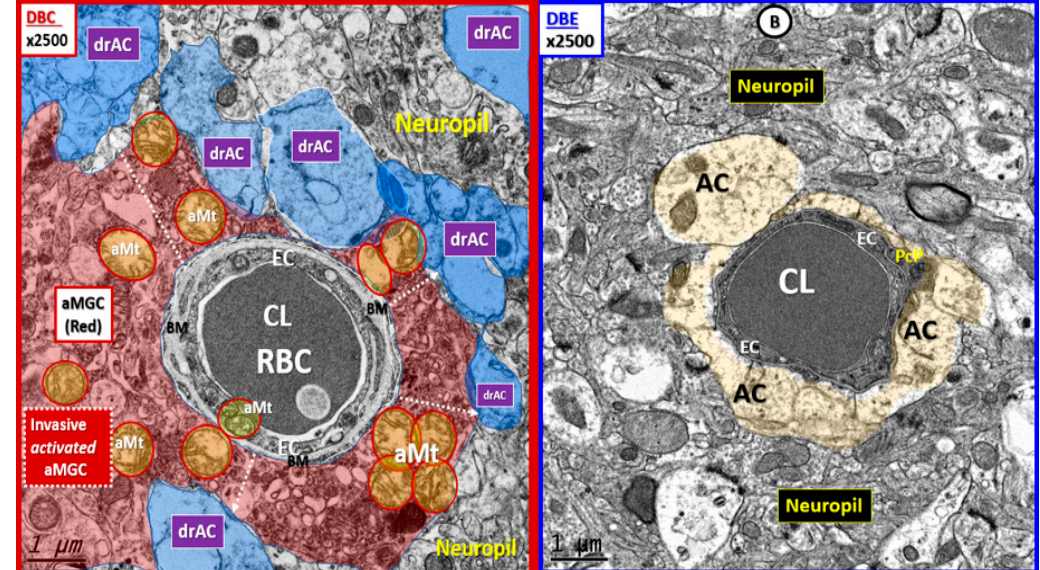
Figure 4. Basement membrane thickening, activated microglia invasion, and detachment of astrocyte foot processes are protected with empagliflozin. Panel ( A ) depicts the invasion of the activated MGC (aMGC) to totally engulf the NVU with detachment of AC end-foot processes (pseudo-colored blue; drAC = detached retracted astrocyte). Also, note the aberrant mitochondria (aMt) (pseudo-colored yellow with red outline) in DBC, which may be responsible for reactive oxygen species (ROS) production and leakage. Dashed arrows depict the detachment and retraction of the AC associated with aMGC invasion of the NVU. Panel ( B ) illustrates how empagliflozin protects the NVU from aberrant remodeling in DBE. Note the intact AC end feet (pseudo-colored golden) and that the mitochondria in DBE are electron dense and not aberrant as in the DBC. Panel ( B ) is a higher magnification of panel F in Figure 3. Magnification 2500 × ; scale bar = 1 µ m. aMGC = activated microglia cell; aMt = aberrant mitochondria; drAC = detached retracted AC; EC = endothelial cell; CL = NVU capillary lumen; Pc = pericyte foot process; RBC = red blood cell.